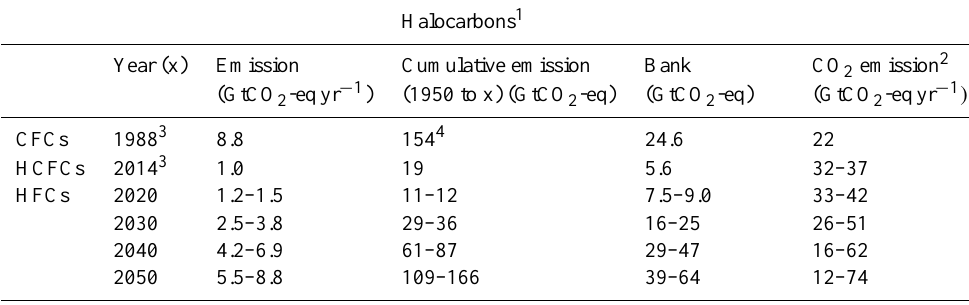
Table 2. Emissions and banks of CFCs, HCFCs, and HFCs, and emissions of CO 2